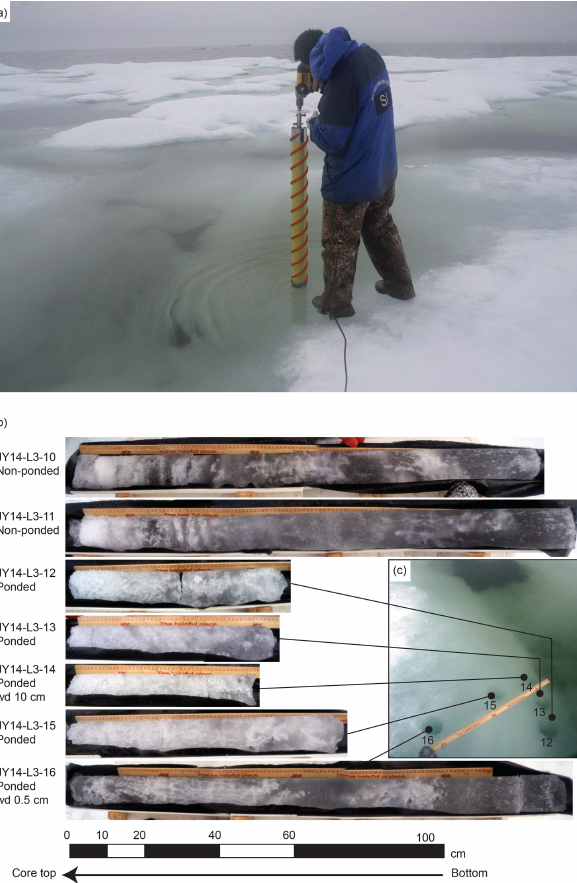
Figure 6. (a) Photograph of the part of a rotten floe sampled on 14 July 2015 (JY14-L3). Ponded and non-ponded areas visi- ble in the picture were drilled for core samples. (b) Several cores drilled from the JY14-L3 floe (JY14-L3-10–JY14-L3-16) showing the variability in length and character of ice from non-ponded ar- eas vs. from beneath pelt ponds. (c) Region of ponded ice that was drilled to collect the ponded ice cores shown in (b) . Cores JY14- L3-12–JY14-L3-14 were drilled from ice at a water depth (“wd” in legend) of ∼ 10cm, JY14-L3-15 was drilled from an intermediate depth, and JY14-L3-16 was drilled from a water depth of ∼ 0 . 5cm.